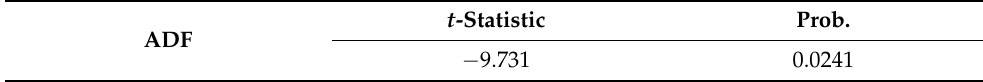
Table 4. Kao residual cointegration test.